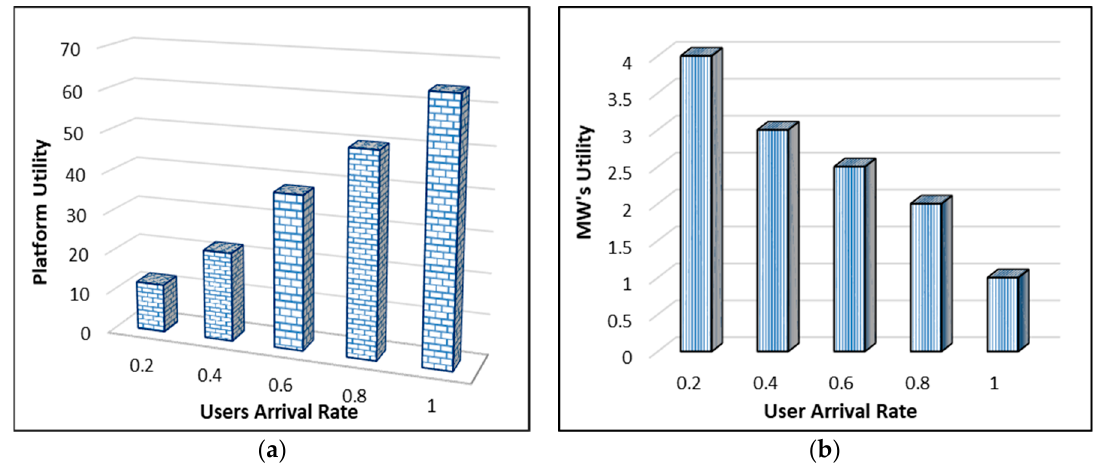
Figure 7. Users arrival rate compared with utility for ( a ) Platform and ( b ) MWs.